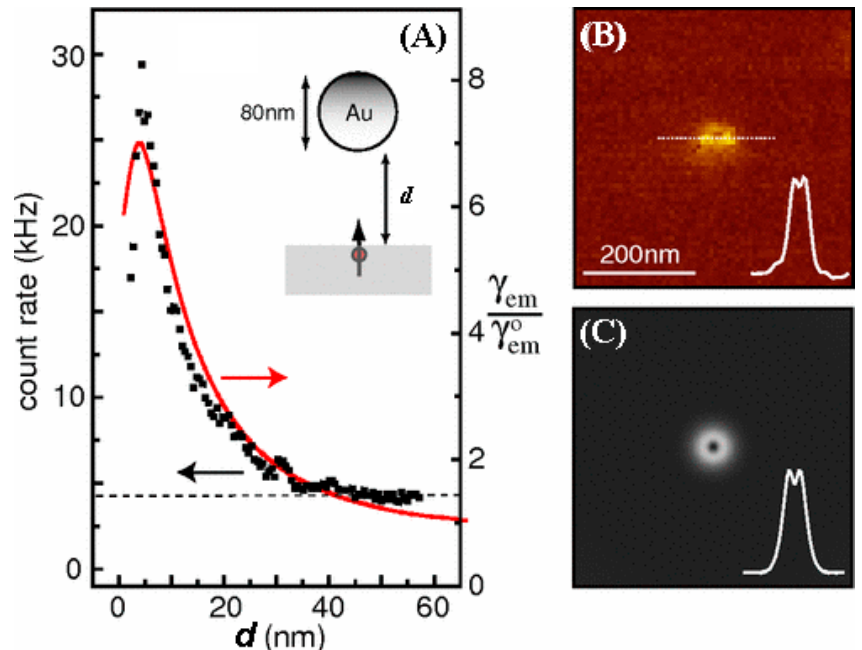
Figure 4. ( A ) The distance dependence of a fluorophore in the vicinity of a metal nanoparticle on the resulting fluorescence rate is shown. The solid and dotted data are from theoretical and experimental outcomes, respectively; ( B ) The fluorescence image is acquired from a single fluorophore molecule located at 2 nm away from the metal. The dip in the center is due to fluorescence quenching; ( C ) Corresponding theoretical image for ( B ) is provided. Reproduced with permission from Ref. [76] Copyright (2006) American Physical